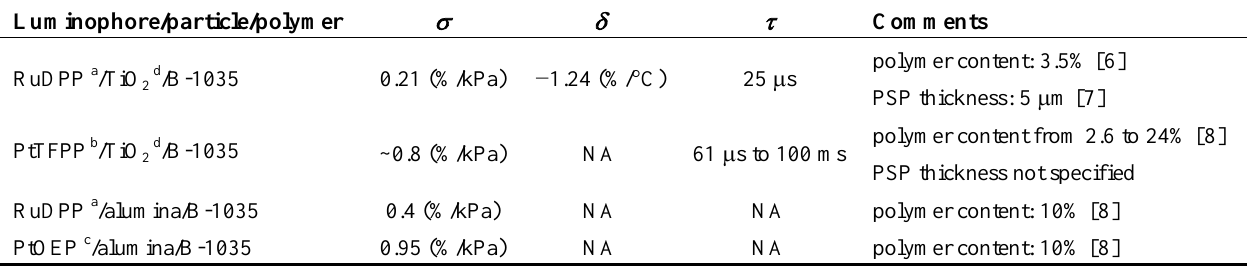
Table 1. Summary of PC-PSP characterizations in the previous